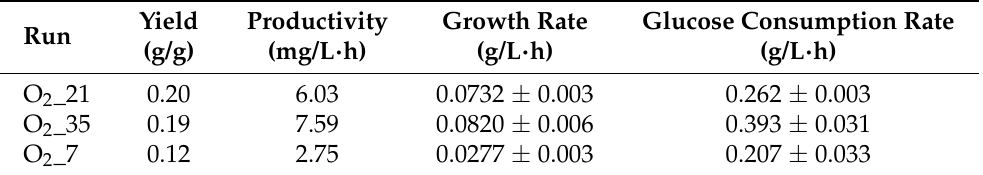
Figure 3. The microbial growth data for all experimental runs was averaged in x - and y -direction. Time-shifted to start their mass-transfer limited growth at the same point in time (vertical line). The error bars show the standard deviations in the results from the triplicate repeat runs. Table 2. The effect of aeration feed composition on yield, productivity, growth rate, and glucose consumption rate. The standard deviation was calculated for each slope and shown in the slope